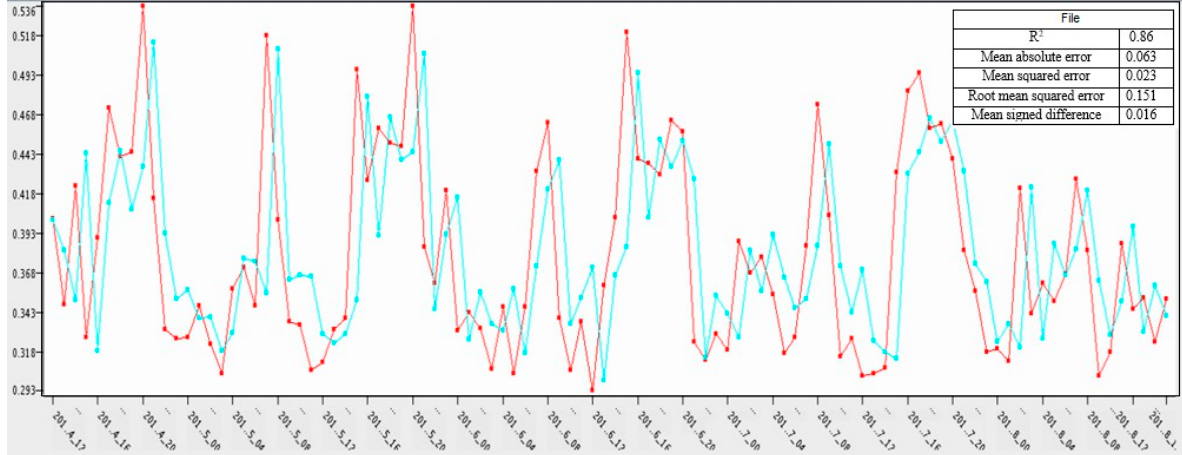
Figure 11. Output for statistics node and graph for AR (i.e., blue colour represents the actual value while the red colour represents the predicted values).